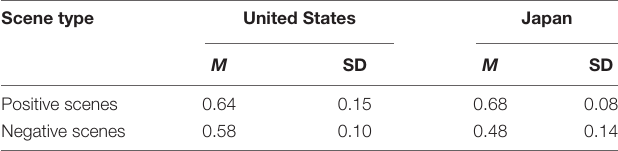
TABLE 1 | Proportion of the actor